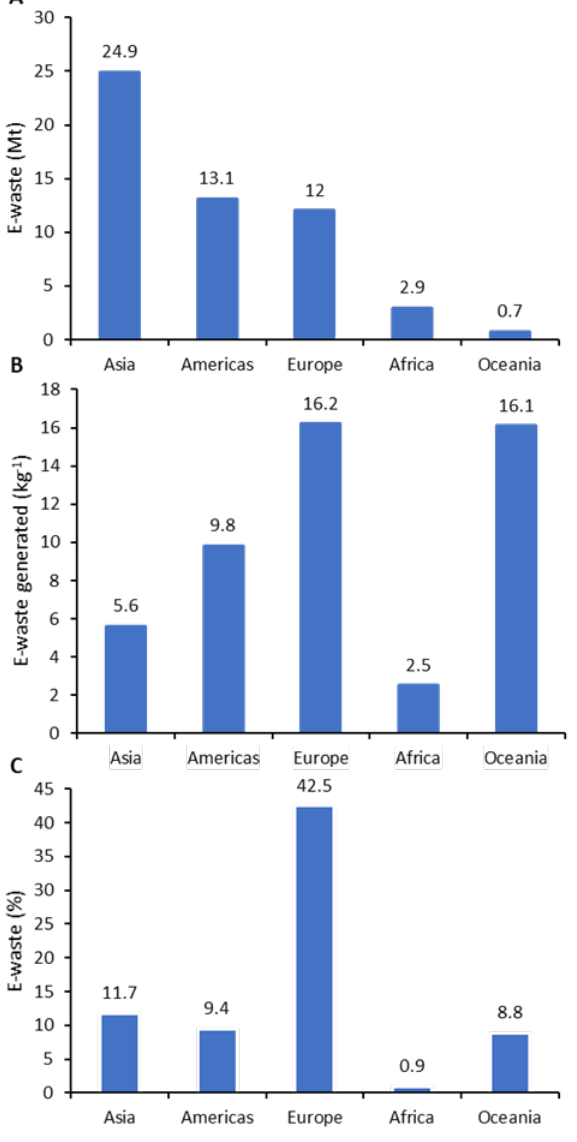
Figure 3. ( A ) Total e-waste generation, ( B ) e-waste generated per capita and ( C ) recycling rate in various regions in 2019 [5].